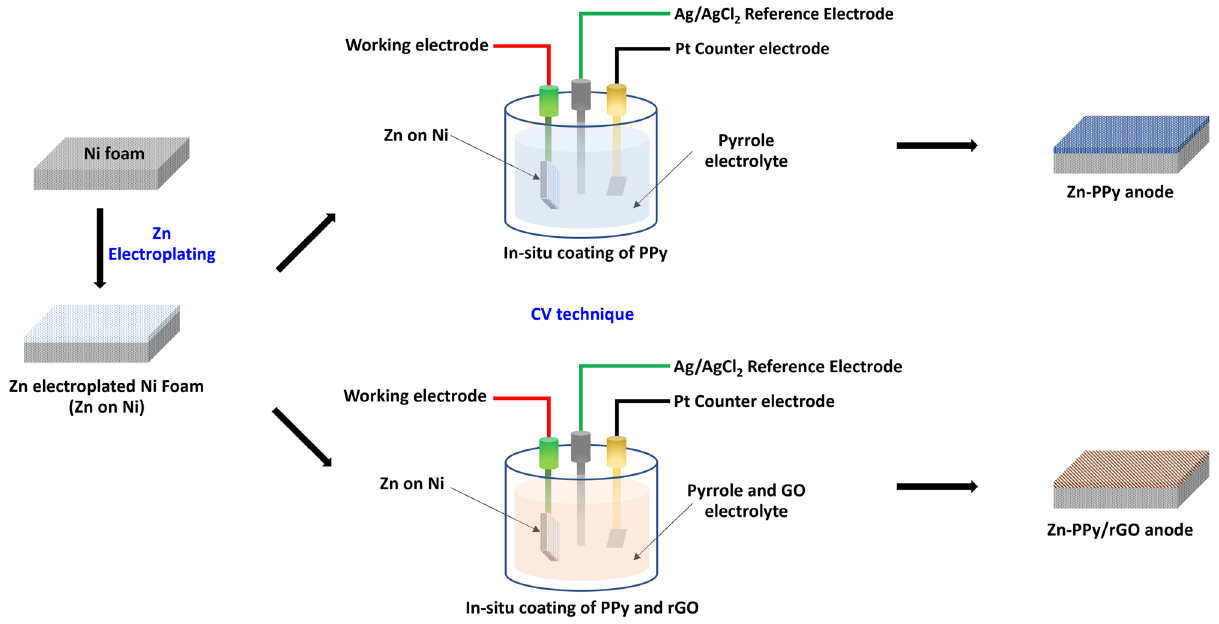
Figure 1. Schematic of the preparation process of Zn-PPy and Zn-PPy/rGO